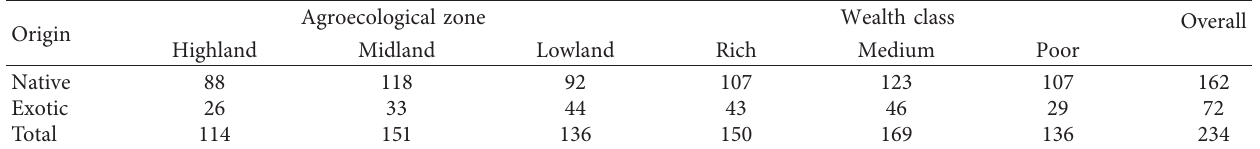
Table 2: Origin of plant species along agroecological zone and wealth class of the study